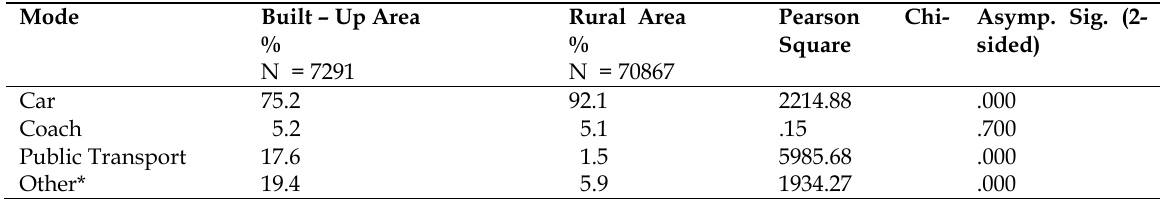
Table 6. Mode of Transport Used to Access NT Properties by Location of Property.